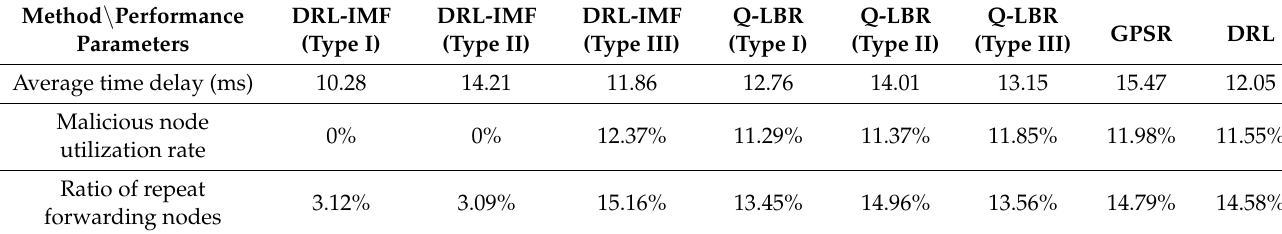
Table 4. Performance statistics of the